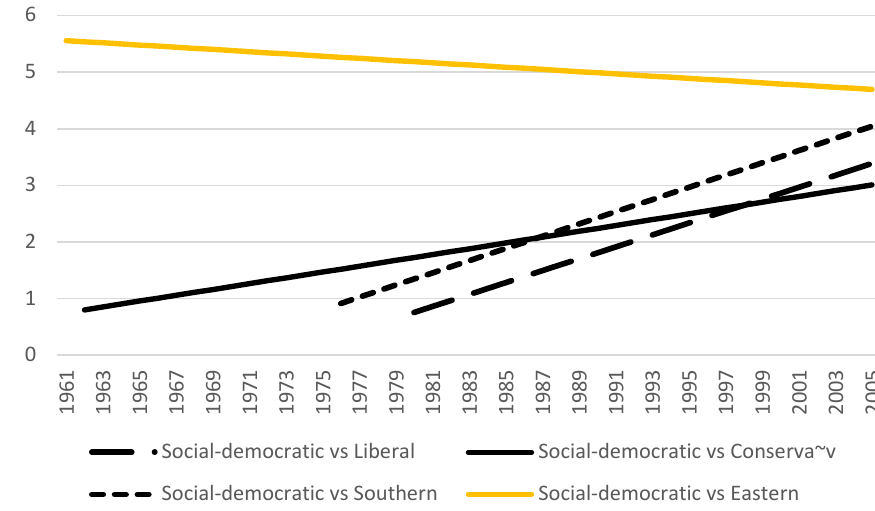
Figure 3. Change in the Difference between Policy Clusters in Average Age at First Marriage. Note: Any non-linearity is due to rounding errors. Only effects that are significant at the 0.05 level are displayed.